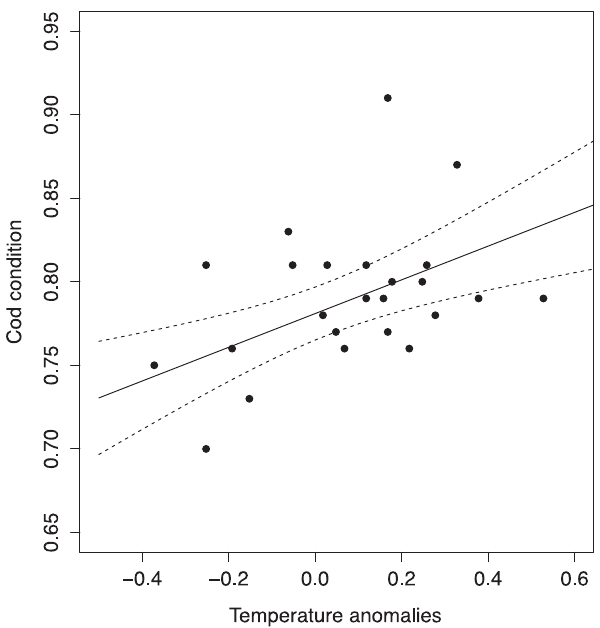
Figure 3. Harvest control rules (HCRs). They determine the total allowable catch (TAC) of the NGSL cod stock in year t + 1 from the spawning stock biomass (SSB) in year t. B lim and B rec are the limit and recovery biological reference points, respectively.